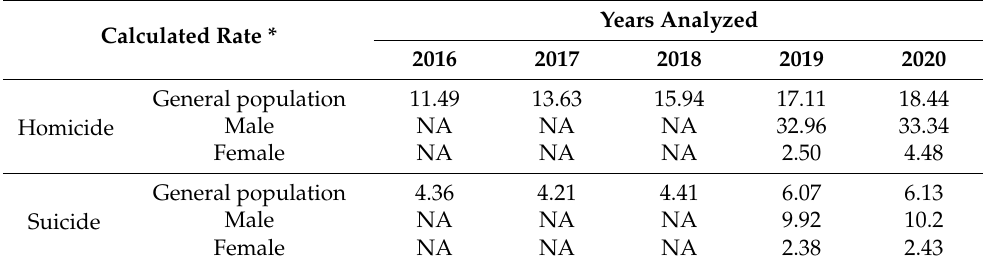
Table 1. Homicide and suicide rates in Mexico City by gender in the period from 2016 to 2020. Calculated Rate